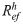
Estimation of Model SIR in Period 1 (October/1995—September/2000).(a) observed incidence (O) and adjusted i (E), (b) m3/m, (c) Refh (h) and Refm (m), and (d) Ref=Refh×Refm.